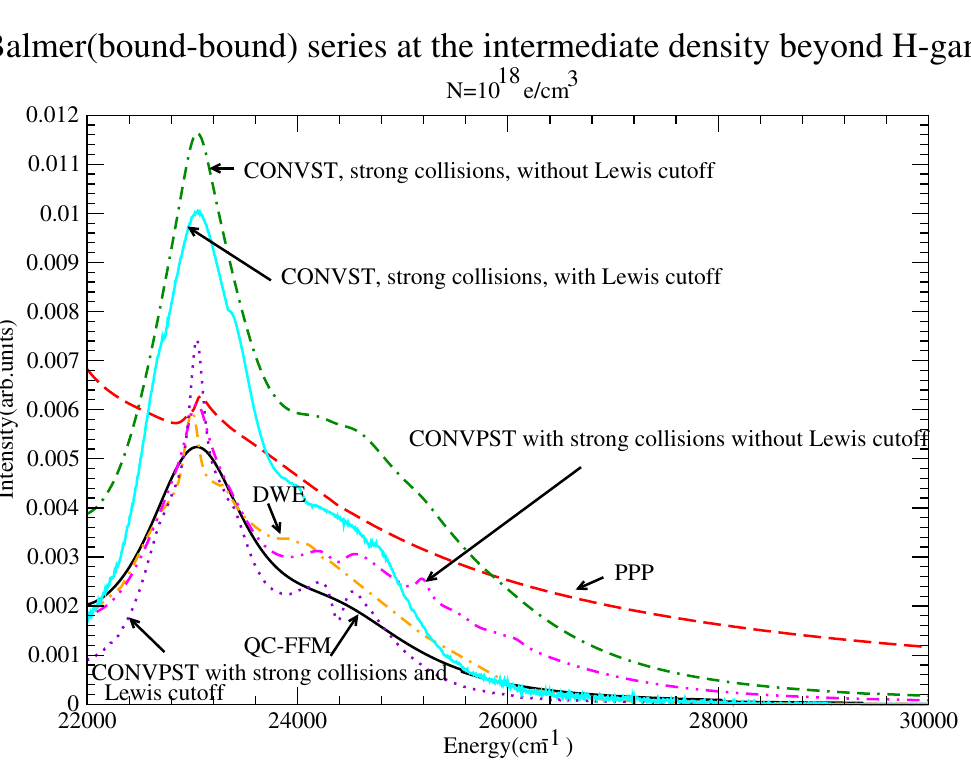
Figure 7. Balmer Series limit region with and without the Lewis cutoff for the intermediate density. Shown are PPP (red dashed), QC-FFM (back solid) , DWE (orange dash-dotted), CONVST without Lewis cutoff (green dot-double dashed), CONVST with Lewis cutoff (cyan solid), CONVPST without Lewis cutoff (magenta dash-double dotted) and CONVPST with Lewis cutoff (violet dotted). All CONV runs include strong